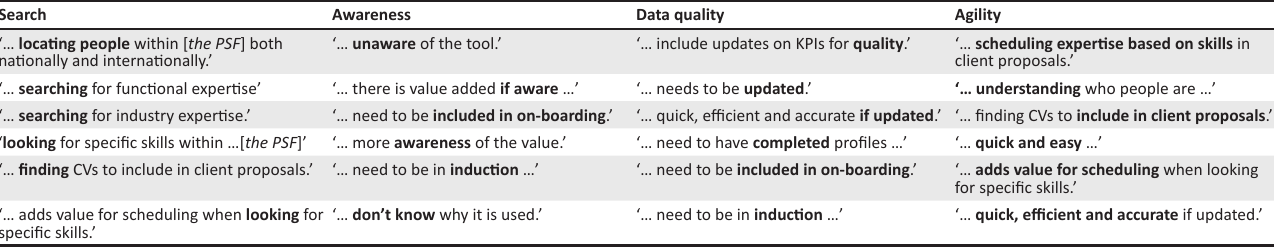
TABLE 2: Verbatim feedback from interviews for expert locator tool (emphasis added). Search Awareness Data quality